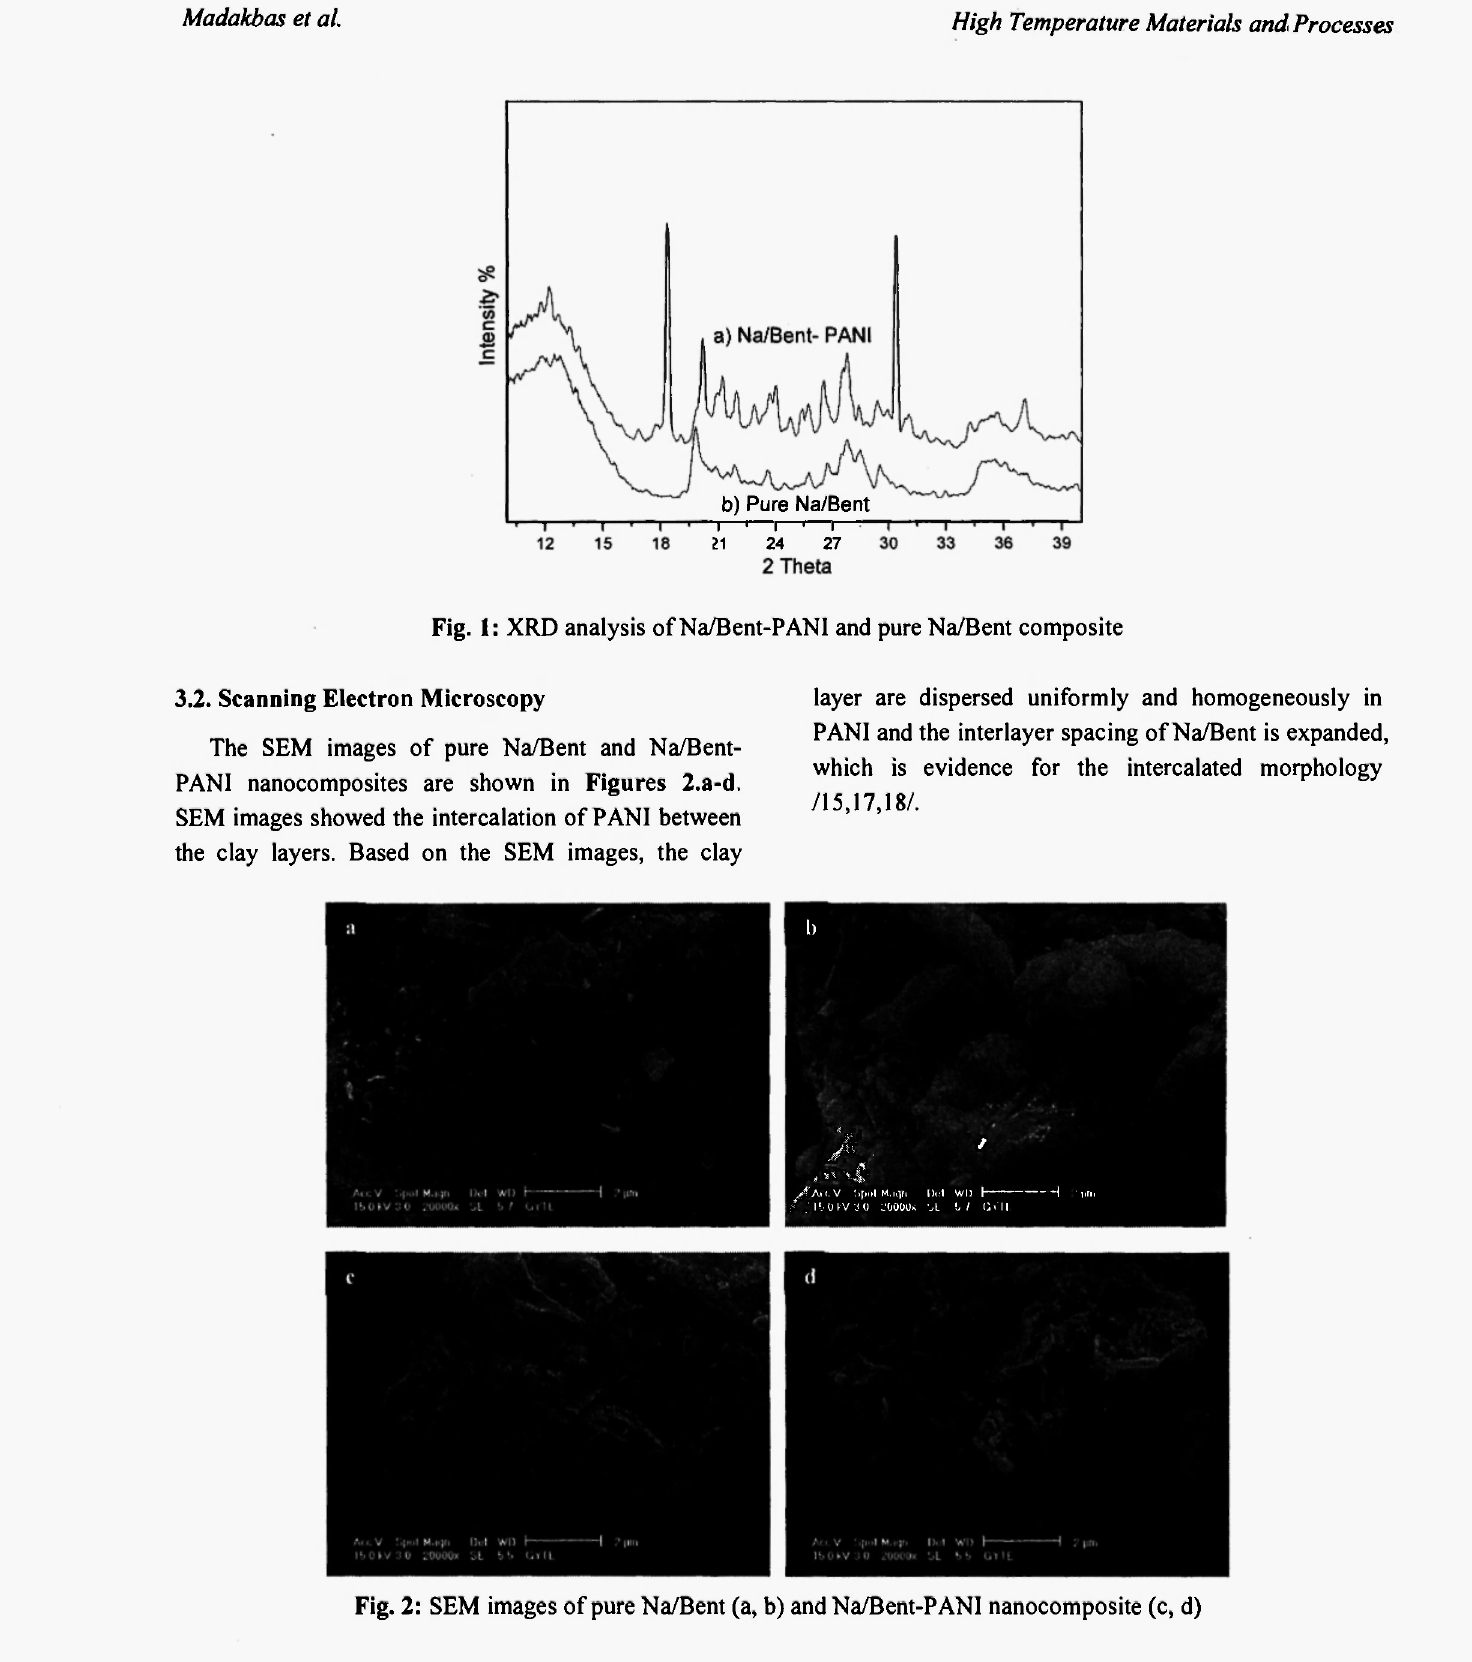
Fig. 2: SEM images of pure Na/Bent (a, b) and Na/Bent-PANI nanocomposite (c,